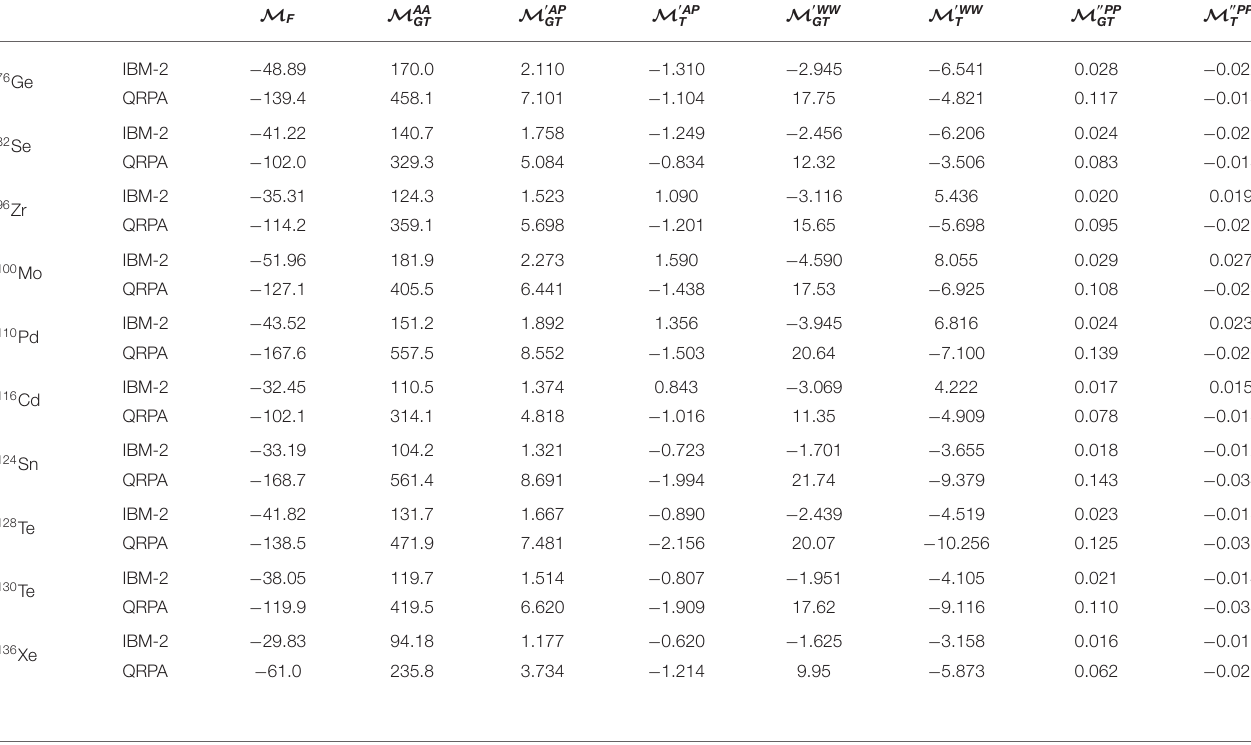
TABLE 4 | Nuclear matrix elements (NMEs) for the heavy neutrino exchange 0 νββ decay mechanism evaluated in the interacting boson model (IBM-2) and quasiparticle random phase approximation (QRPA) as described in the text.